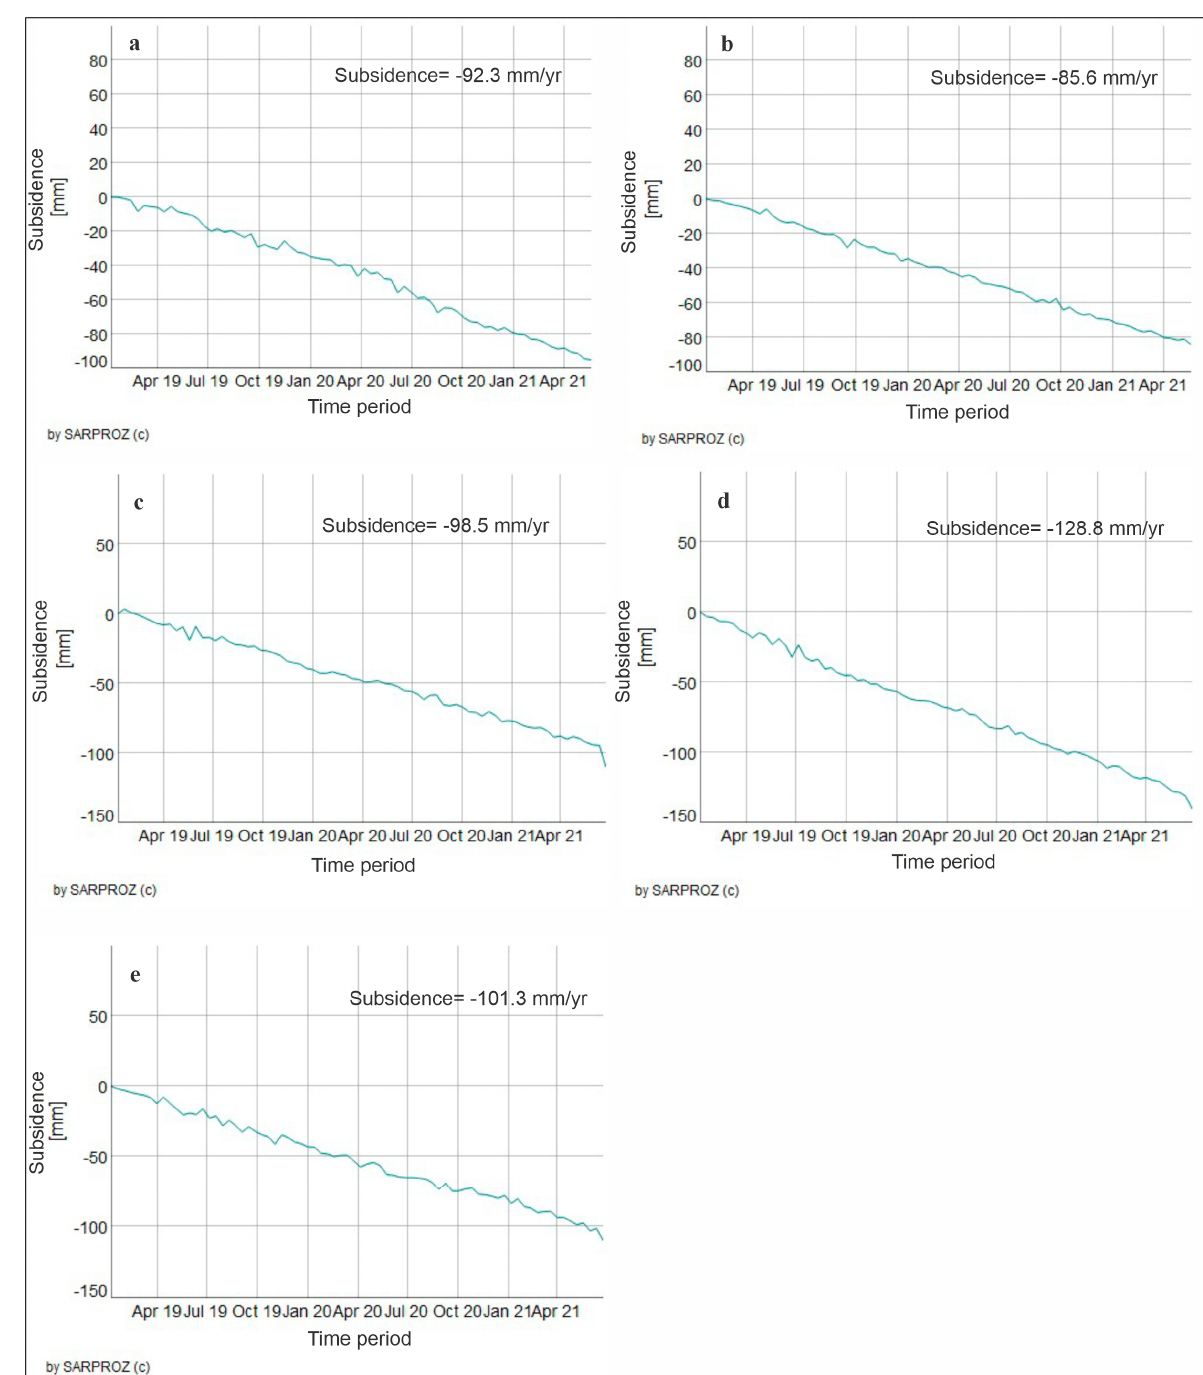
Figure 12. Subsidence along with PS points ( a–e ) ( x -axis is the time from 2019 – 2021; y -axis represents subsidence) .